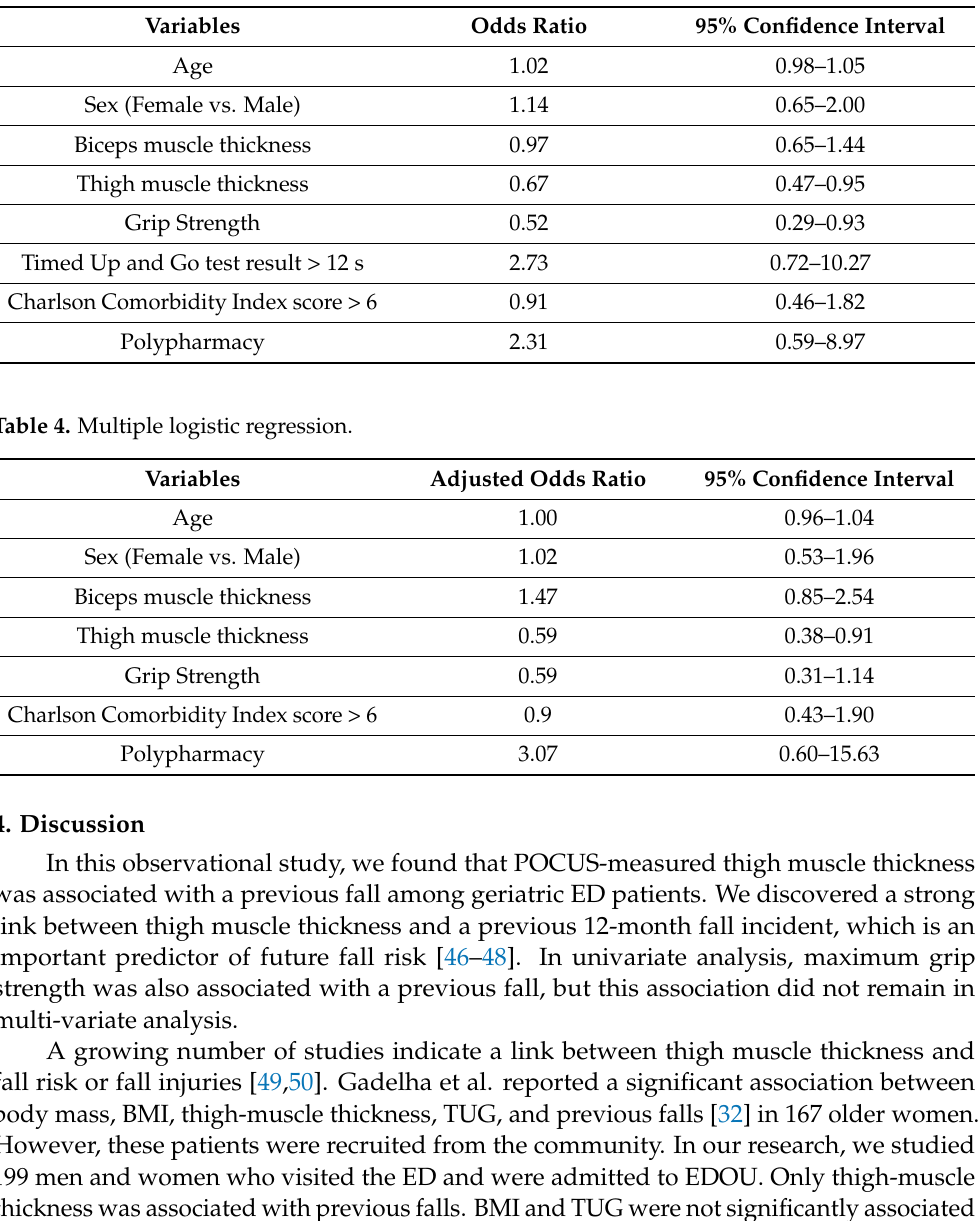
Table 3. Univariate logistic regression.